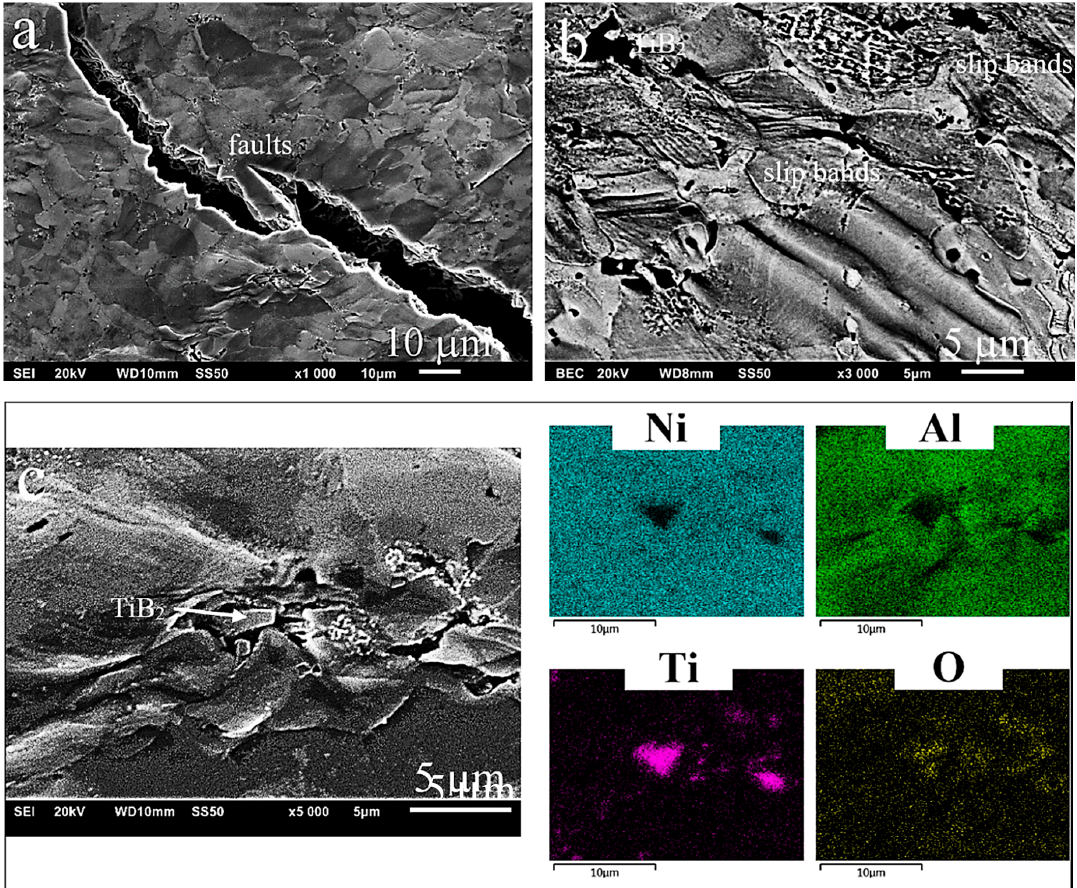
Figure 10. High-temperature compression test: composite microstructure ( a ) after deformation at a temperature of 873 K, cracks in the form of faults, ( b ) at a strain level of 0.3, ( c ) blocking of slip and piling up of grains on the particle of TiB 2 , map identification of individual microstructural constituents, including TiB 2 particles and oxides.